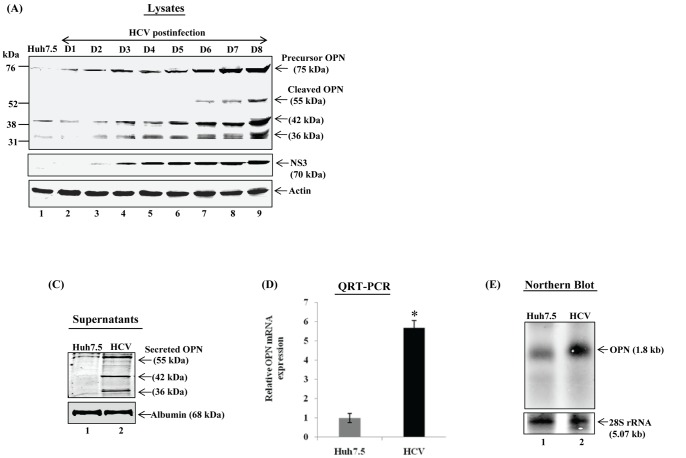

HCV activates OPN expression and secretion.
(A) Mock (Huh7.5) and HCV-infected cells at days 1 to 8 postinfection
                            were harvested and equal amounts of cellular lysates were subjected to
                            immunoblot analysis using anti-OPN antibody. HCV NS3 represents HCV
                            infection and actin was used as protein loading control. (B) Huh7.5
                            cells were infected with HCV at M.O.I. of 1. The cell culture
                            supernatants were collected from HCV-infected cells at days 1 to 7, and
                            were incubated with naive Huh7.5 cells. At day 4 postinfection, equal
                            amount of cellular lysates were subjected to western blot analysis using
                            anti-NS5A antibody. (C) Mock and HCV-infected cells at day 8
                            postinfection were incubated in serum free media overnight. Equal
                            amounts of cell culture supernatants were subjected to western blot
                            analysis using anti-OPN antibody. Immunoblot with anti-albumin was used
                            as protein loading control. (D) HCV induces OPN mRNA expression. Total
                            cellular RNA was extracted from mock and HCV-infected cells (day 8)
                            followed by quantitative RT-PCR using OPN-specific primers. OPN gene
                            expression was normalized by 18S rRNA. The values represent the means+SD
                            of three independent experiments performed in duplicate. *denotes
                            p<0.05 compared to mock cells (Huh7.5). (E) Equal amounts of
                            cellular RNA from mock and HCV-infected cells as describe in panel D,
                            were subjected to northern blot analysis using OPN probe. 28S rRNA probe
                            was used as internal control.